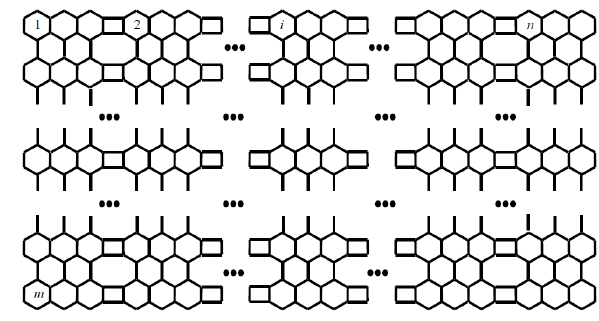
Figure 4: The molecular graph of multiple Anthracene.